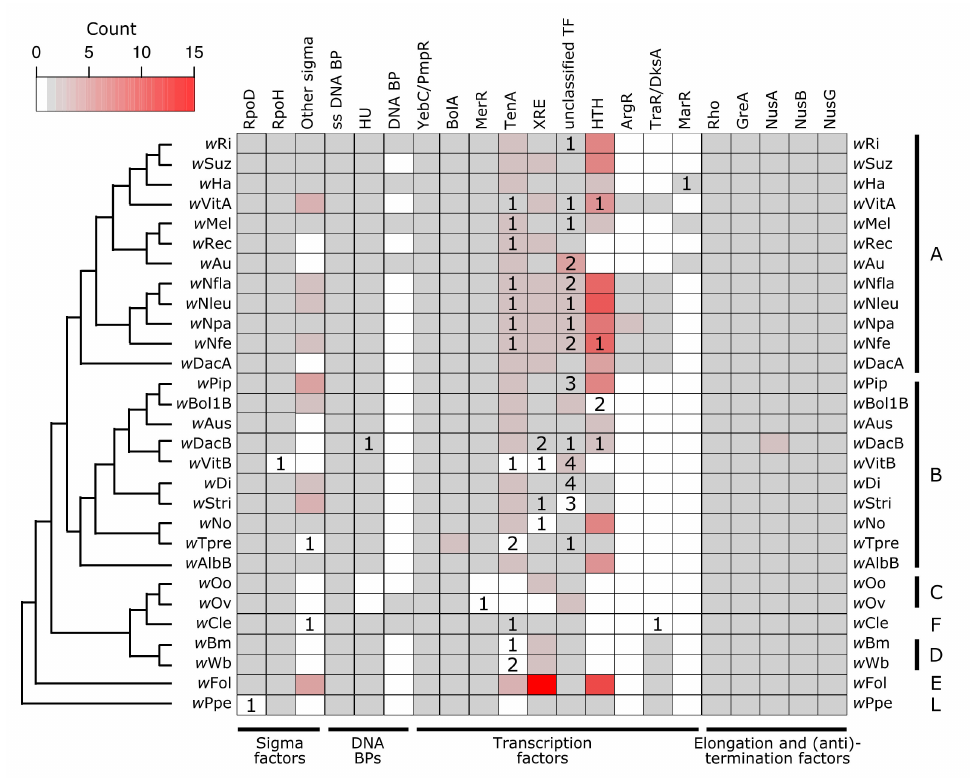
Figure 2. Wolbachia encode for a suite of proteins that are involved in transcriptional regulation. Cladogram was drawn based on previously published Wolbachia phylogenies to show relationships between strains [132–134]. Colors on the heatmap indicate how many putatively functional copies are present within a Wolbachia strain for a given gene, with white indicating no copies, and the grey to red color scale indicating between one and 15 copies. Numbers inside of the heatmap indicate how many additional copies of the gene are present but annotated as pseudogenized or partial. Supergroup membership (monophyletic clades of Wolbachia historically used for designation) of the strains is indicated with the capital letters on the right side of the heatmap. Abbreviations: ss = Single-Stranded; BP = Binding Protein; TF = Transcription Factor; HTH =